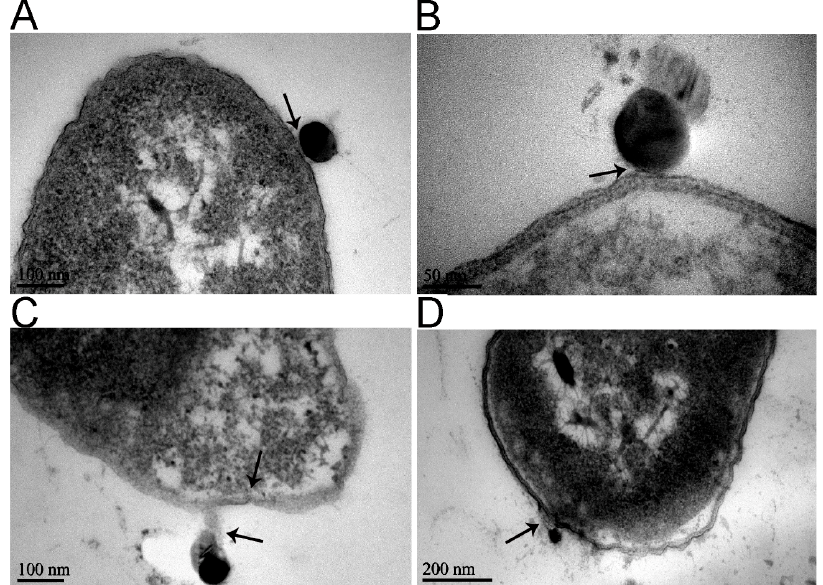
Figure 5. Transmission electron microscopy of the process of the destruction of E. coli cell membranes by iron oxide nanoparticles. The bacteria, at 10 7 colony forming units (CFU)/mL, were exposed to 0.5 mM iron oxide nanoparticles at 37 °C for 4 h in PBS. ( A ) Iron oxide nanoparticles approach the cell membrane and adhere to the cell surface, as indicated by the arrow; ( B ) Iron oxide nanoparticles adhere to the cell’s outer membrane and tear the outer membrane to be uplifted, as indicated by the arrow; ( C ) Iron oxide nanoparticles adhere to the outer membrane closely to allow outer membrane release. The two regions indicated by black arrows were almost entirely coincident; ( D ) The cell membrane is broken and cytoplasm is released, as indicated by the black arrow.